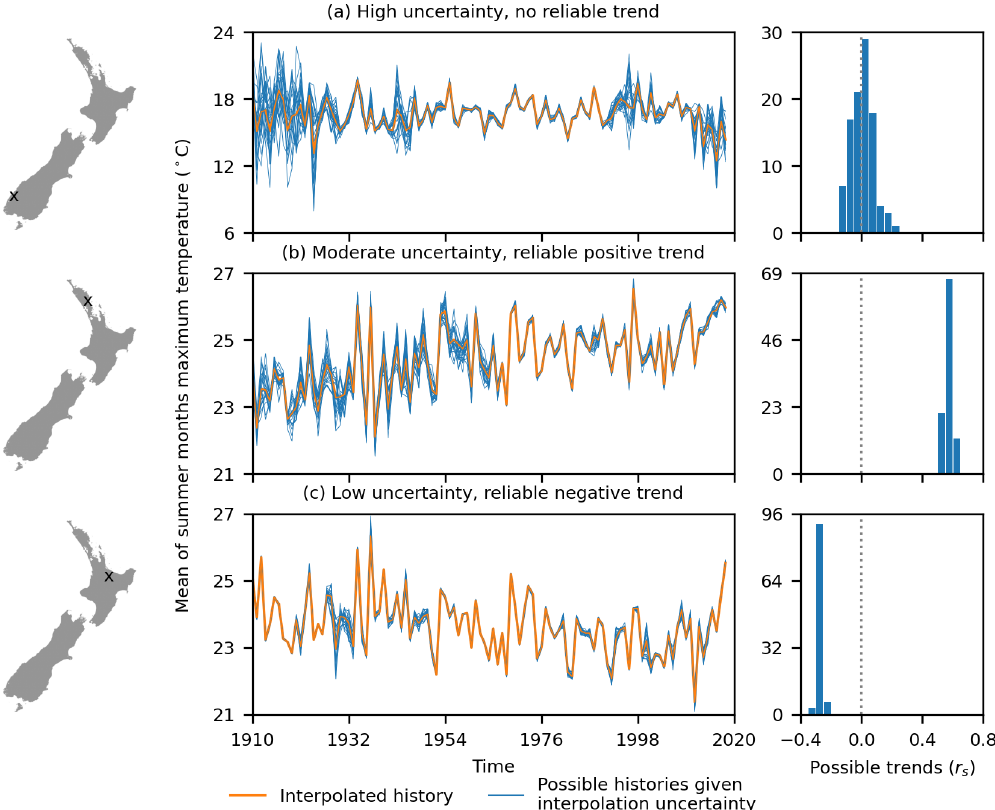
Figure 8. Examples of mean of summer month (December, January, and February) maximum temperature trend analysis that incorporates interpolation uncertainty for three locations in New Zealand. The distribution of trends for the 100 possible histories are shown as Spearman’s rank ( r s ) correlations between temperature and time for locations with (a) high uncertainty, resulting in a wide variety of possible histories with positive and negative trends and hence no reliable trend, (b) moderate uncertainty resulting in some variation in possible histories but all showing a consistent positive trend, and (c) low uncertainty resulting in consistent possible histories and a confident negative trend. For each location, the weather history for the interpolated values is shown along with the first 20 of 100 possible weather histories that are within the range of uncertainty for the interpolated value for each